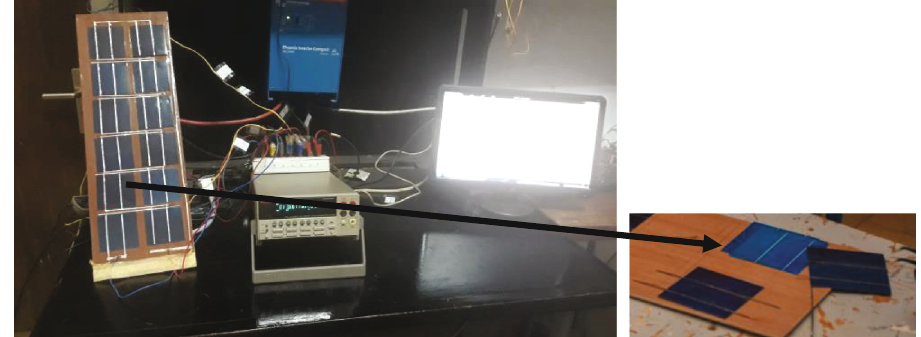
Figure 21: Experimental setup.